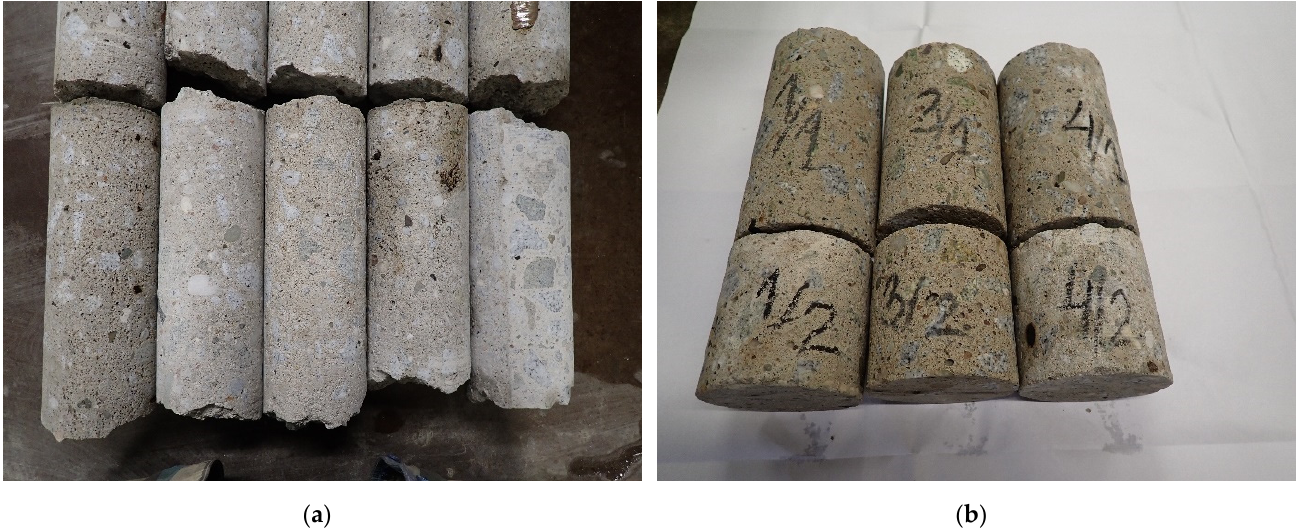
Figure 3. Old cylindrical concrete specimens: ( a ) taken from basement wall using a borehole diamond drill machine; ( b ) example view on some prepared concrete cores.